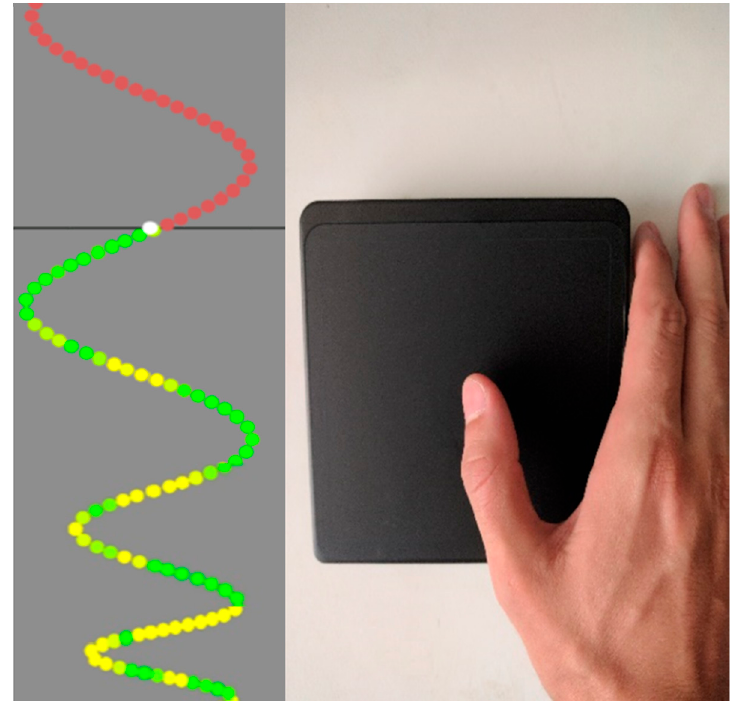
Figure 1. Motor acquisition tracing task (Custom Leap Motion Software Tool). ( Left ): Continuous sinusoidal waves move vertically down a monitor and participants attempted to copy each dot as it passed the black horizontal axis. Color-coded dots show trace accuracy, with the trace changing to green to represent good accuracy and yellow to represent less accurate performance. ( Right ): participant attempted to copy each dot as it passed the horizontal axis, using their thumb on an external touch pad.